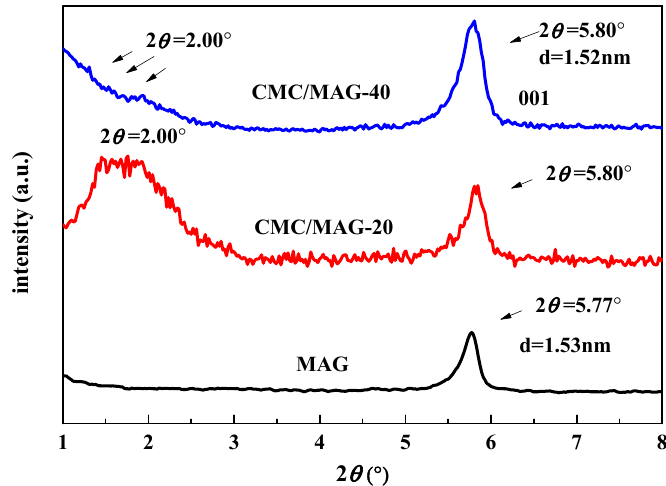
Figure 1. X-ray diffraction (XRD) patterns for magadiite (MAG) (curve black), carboxymethylcellulose (CMC) / MAG–20 (curve red) and CMC / MAG–40 (curve blue).